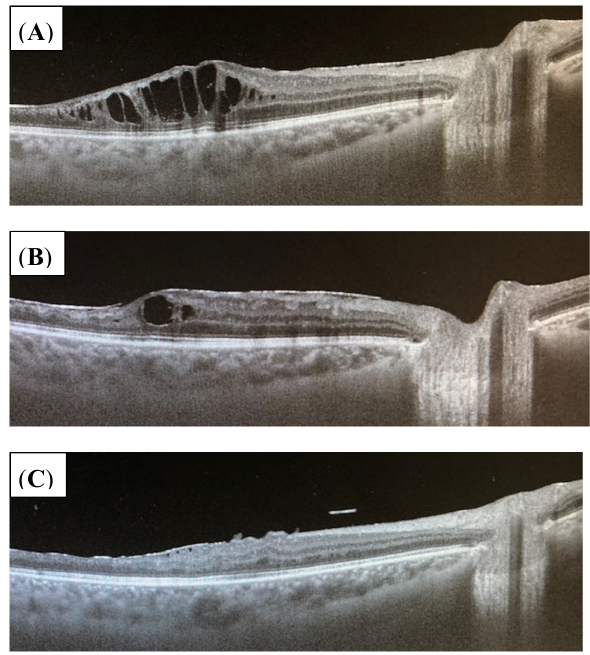
Figure 7. ( A – C ) OCT of the right eye (OD) of patient no. 13 showing cystoid macular edema before treatment ( A ), after 4 months while being on 30 mg/d corticosteroids and azathioprine 150 mg/d ( B ), and at the last follow-up after 41 months during adalimumab 40 mg every 2 weeks sc, methotrexate 10 mg/weekly, and 1 mg/d prednisolone ( C ). Macular edema regressed completely over time. J. Clin. Med. 2022 , 11 , x FOR PEER REVIEW